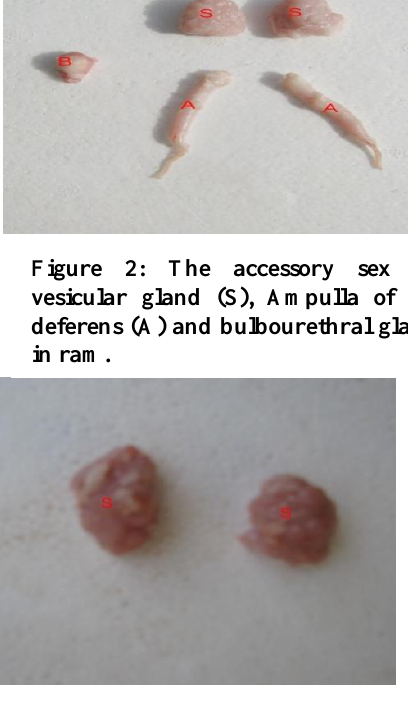
Figure 4: The vesicular gland (S) of ram (right and